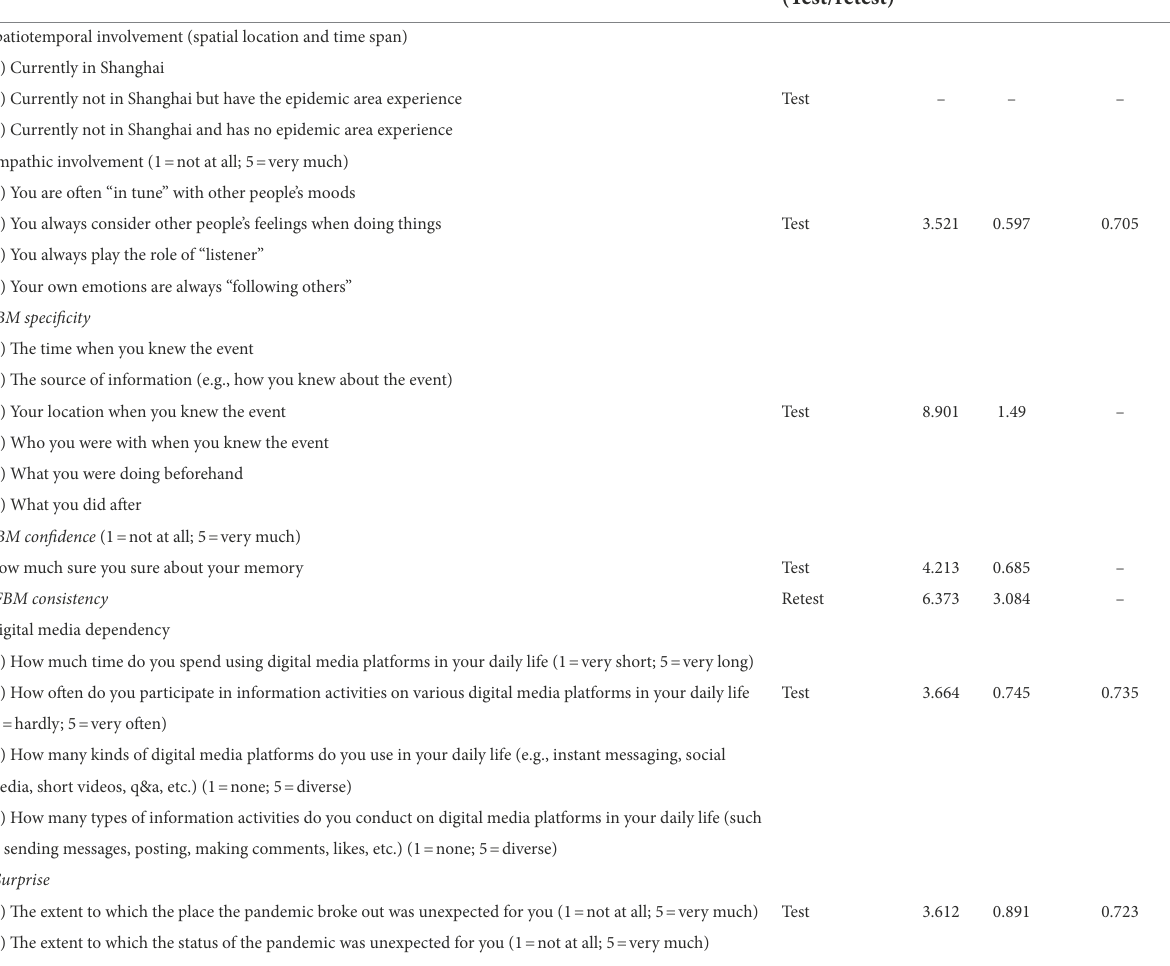
TABLE 2 Questionnaire items, means, standard deviations, and reliabilities of the key variables.